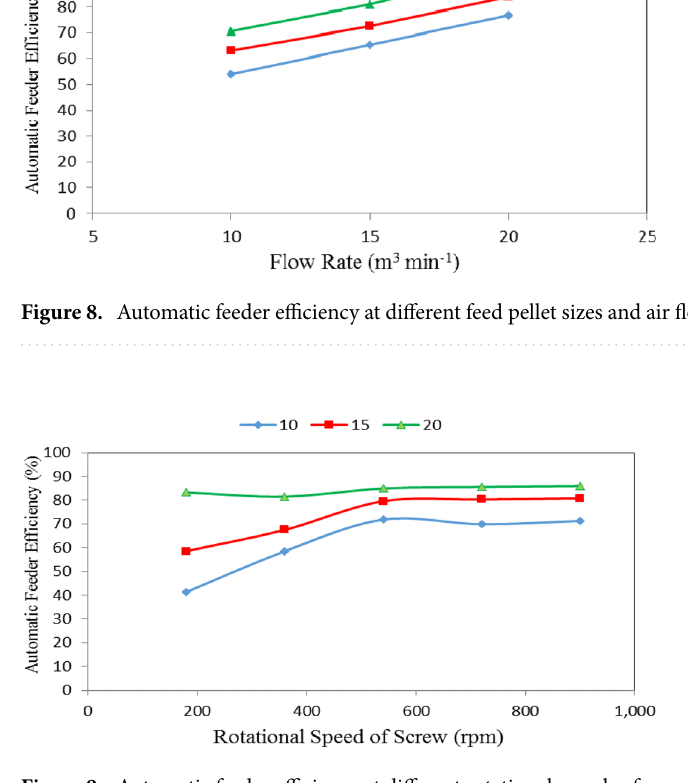
Figure 9. Automatic feeder efficiency at different rotational speeds of screw and air flow